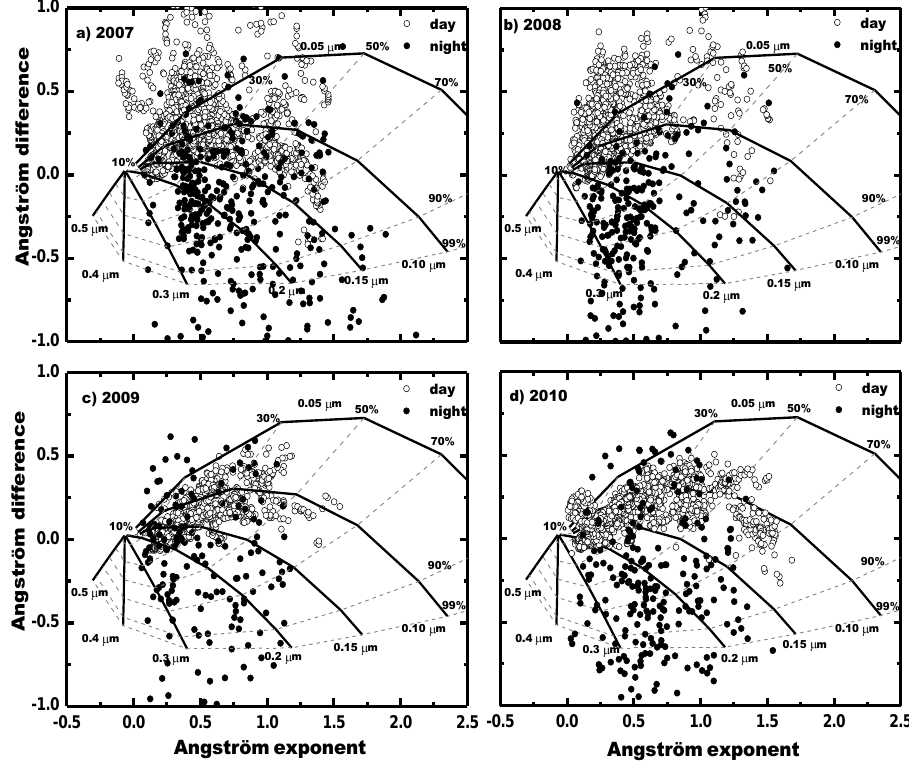
Fig. 7. Angstr¨om exponent difference δα = α (440–670nm) − α (670–870nm) as function of α (440–870nm) at daytime and δα = α (436– 670nm) − α (670–880nm) as function of α (436–880nm) at nighttime, for summer season. (a) For year 2007. (b) For year 2008. (c) For year 2009. (d) For year 2010. Each point presented in that figure corresponds to a single measurement with sun-photometry or 30min average measurements with star-photometry.